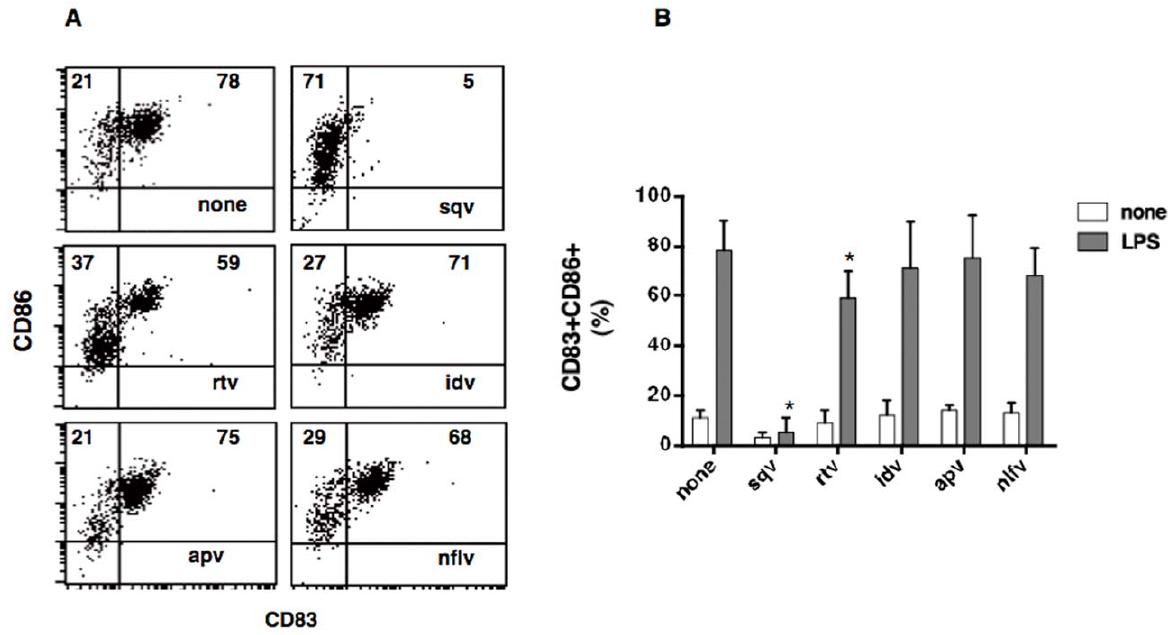
Figure 2. Responsiveness to LPS of immature DCs generated in the presence of HIV-protease inhibitors: immunophenotype. iDCs generated in the presence or in the absence of 20 m M of the indicated protease inhibitor were exposed to LPS (100 ng/ml). After 24 hours, DC were collected, stained with CD83 and CD86 antibodies, and analyzed by flow cytometry. (A) Representative example for dot plots showing CD83 and CD86 expression. (B) Bars graph report mean and standard deviation of CD83 + CD86 + DC percentage calculated on ten independent experiments. (* p , 0.005).